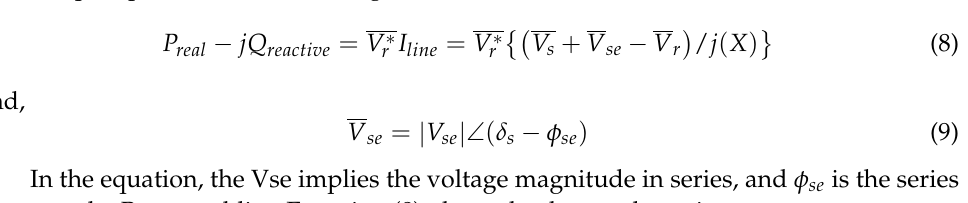
Figure 5. Model of UPFC integration in interlinked hydro systems.